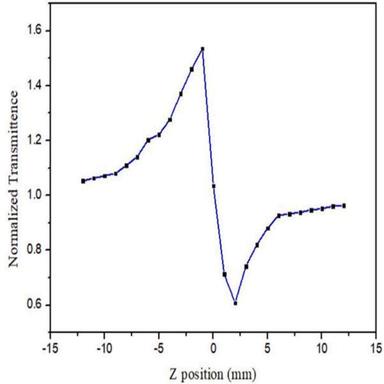
Ratio of Z-scan closed to open aperture curve of G4C3NBM crystal.